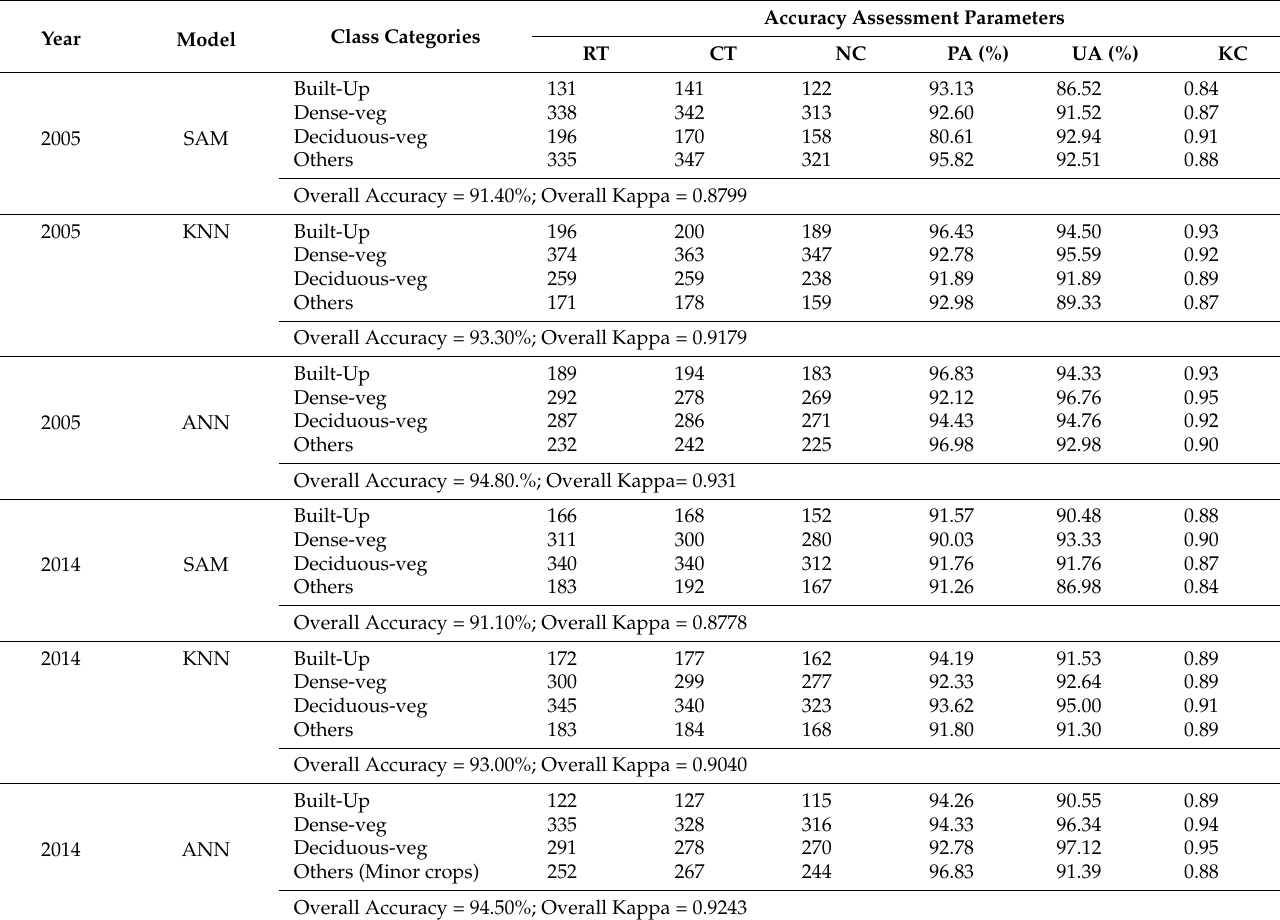
Table 1. Accuracy Assessment of ANN, SAM, and KNN classification of Hyperion EO-1.